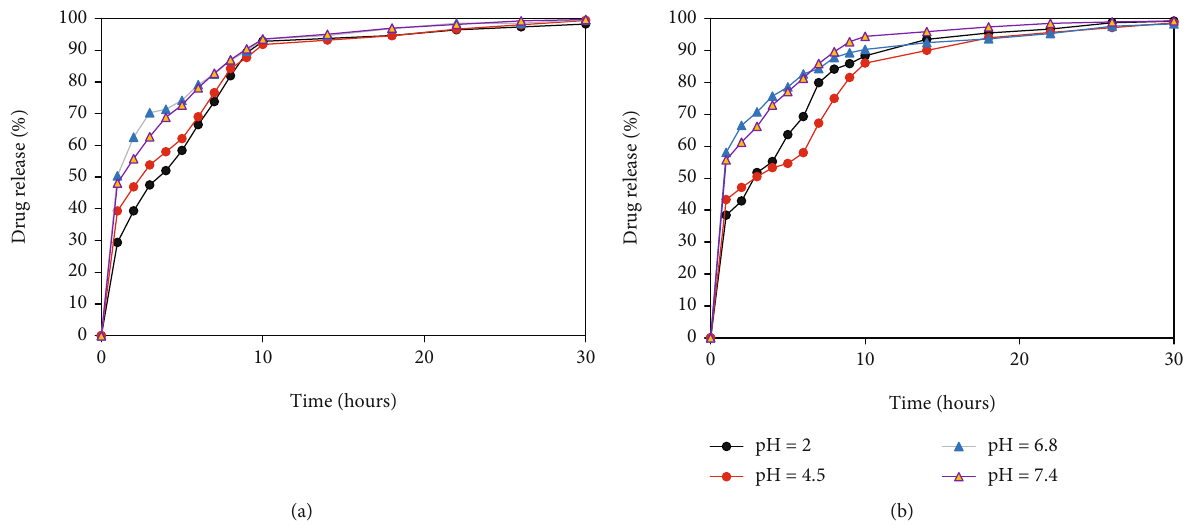
Figure 5: Content of PP released from ACP10 (a) and ACP50 (b) composites versus testing time in di ff erent pH